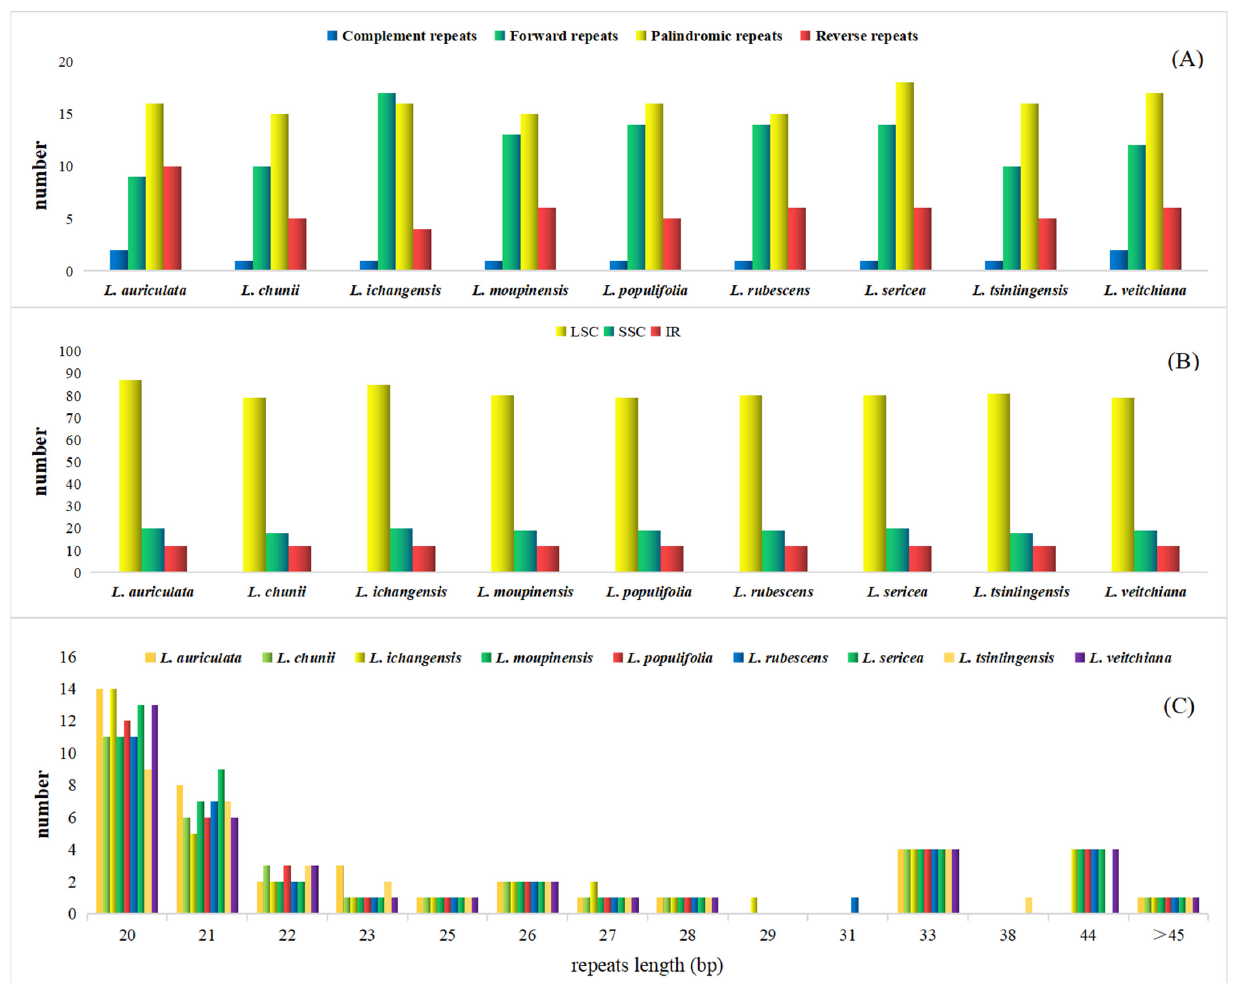
Figure 3. Comparison of microsatellites and oligonucleotide repeats in the chloroplast genomes of Litsea species. ( A ) The number of SSR markers in the LSC/SSC/IR region for nine Litsea species. ( B ) Number of four long repeat sequences in nine species: complement repeats. F represents forward repeats, P represents palindromic repeats, R represents reverse repeats, C represents complement repeats. ( C ) number of long repeat sequences with different lengths in nine species. Different colors in the figure represent different long repeat sequence types. Species from left to right are: L. auriculata , L. chunii , L. ichangensis , L. moupinensis , L. populifolia , L. rubescens , L. sericea , L. tsinlingensis , L. veitchiana